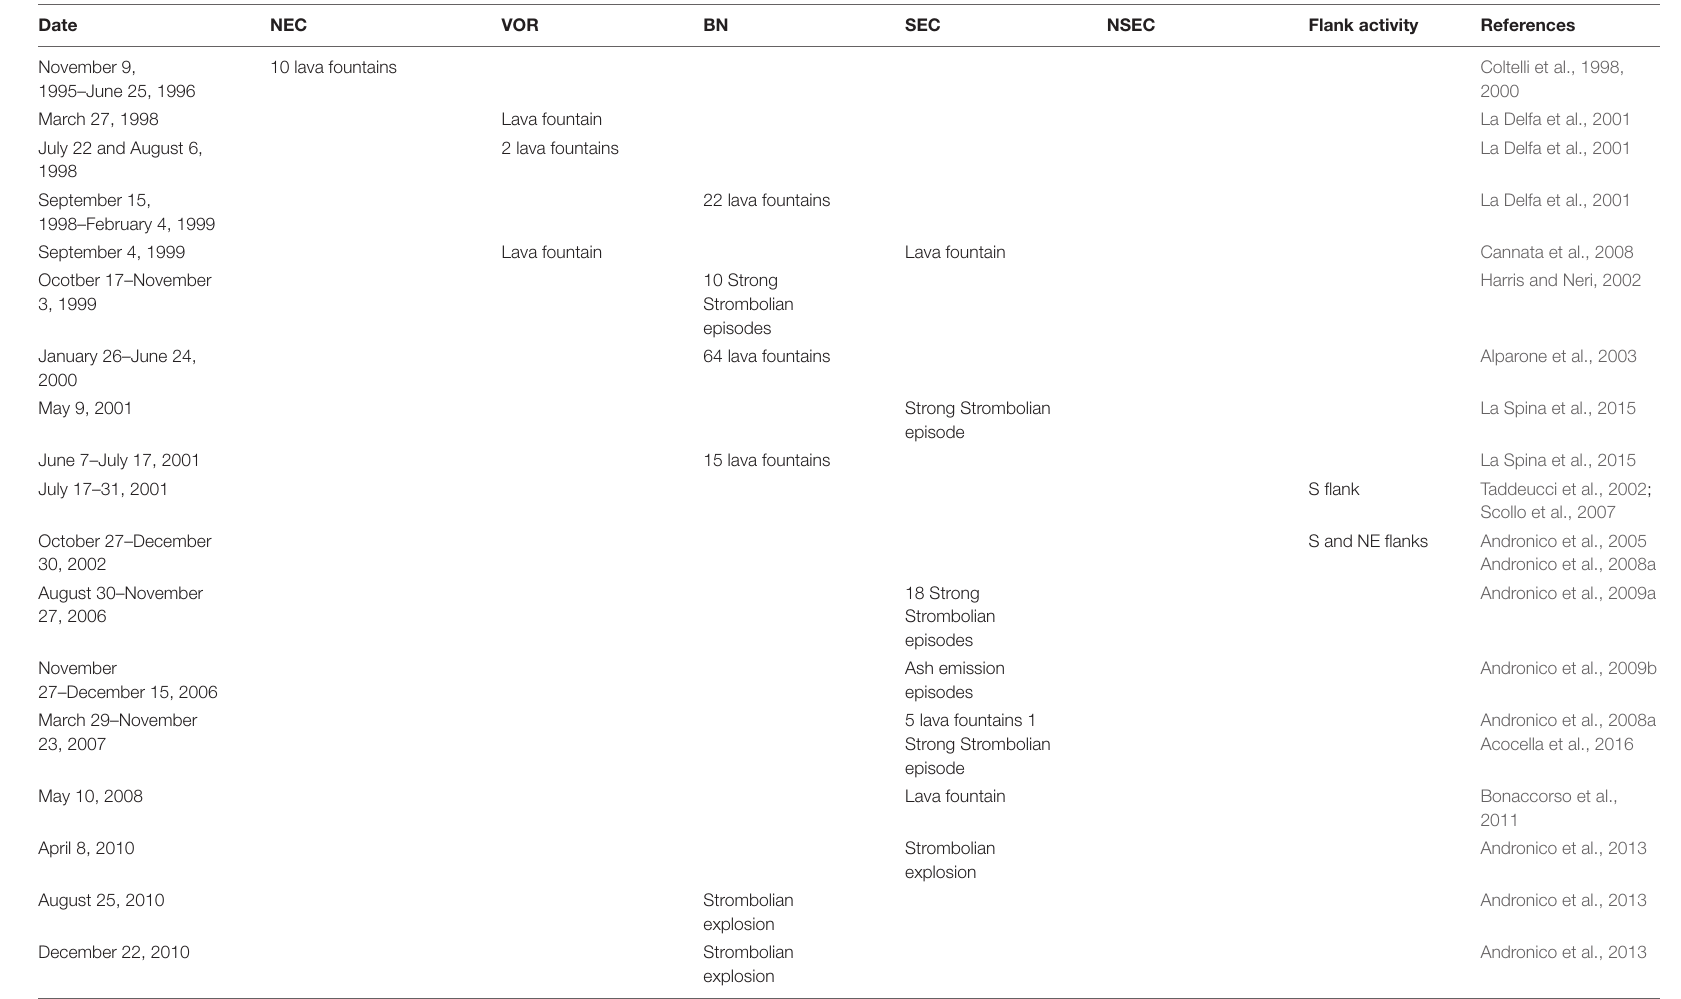
TABLE 1 | Summary of the explosive activity (summit eruptions, i.e., lava fountains, strong Strombolian episodes, Strombolian explosions and sustained ash emissions, and flank eruptions) producing significant ash emission up to tens–hundreds of kilometres of distance away from Etna from 1995 to